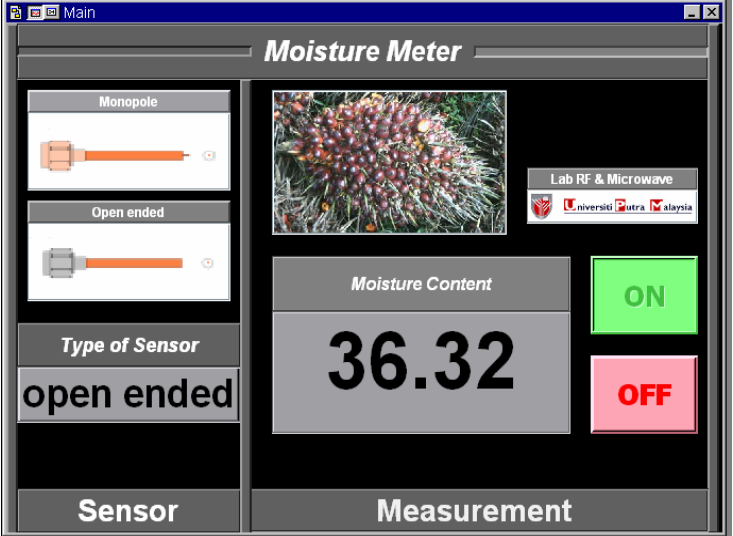
Figure 6. Panel View of VEE Program to determine moisture content in oil palm